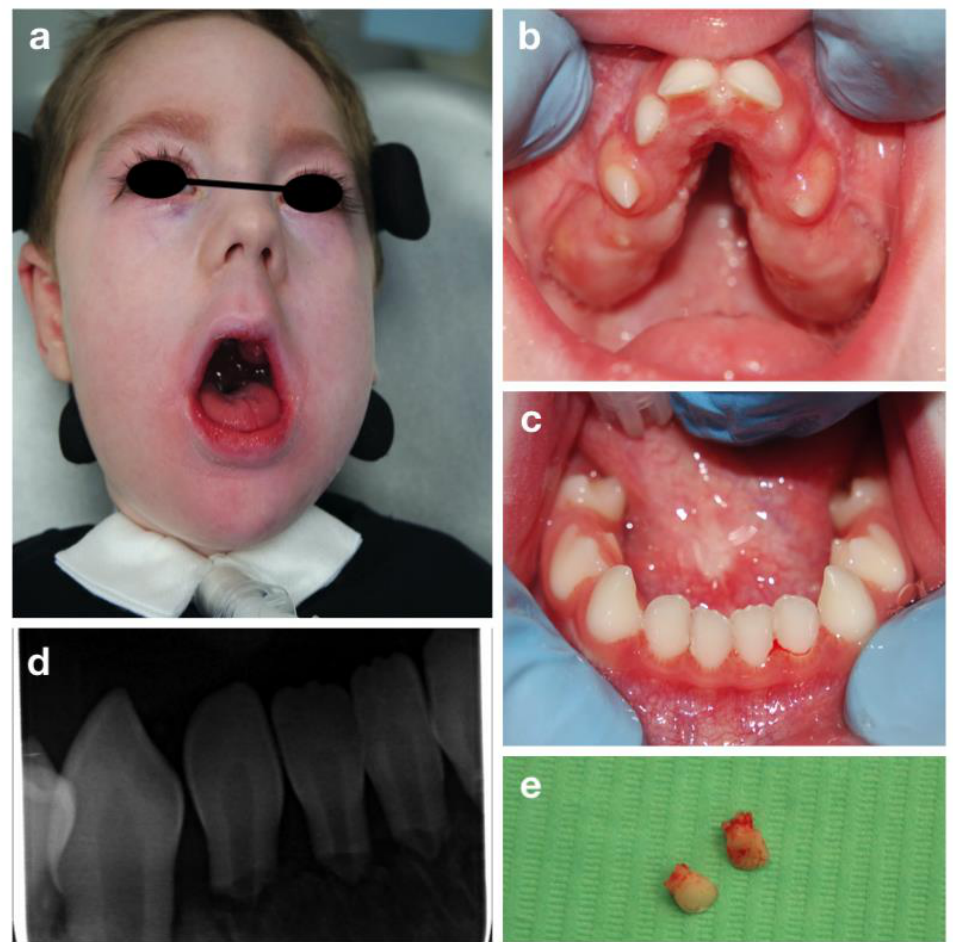
Figure 3. Congenital nemaline myopathies: extra-oral ( a ), intra-oral pictures ( b , c ), periapical radio- graph of lower incisors ( d ) and the upper incisors after extraction ( e ).